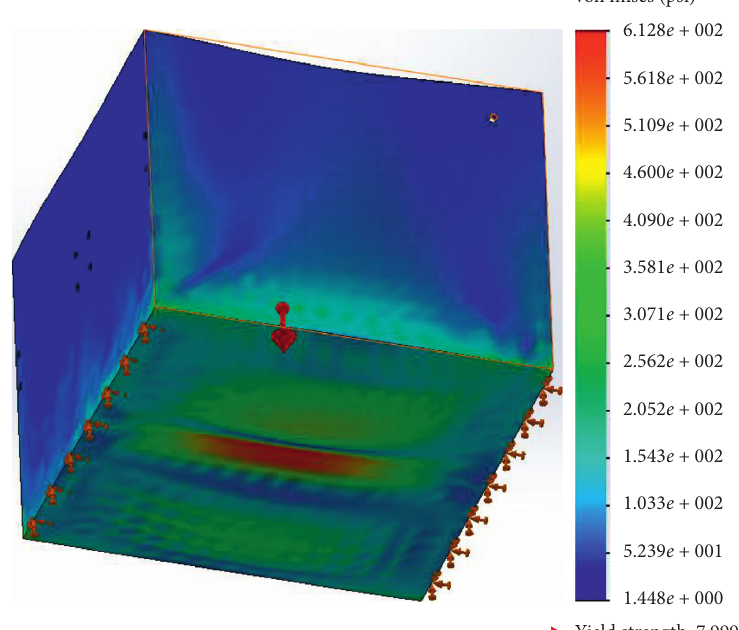
Figure 2: Finite element analysis (FEA) of the battery